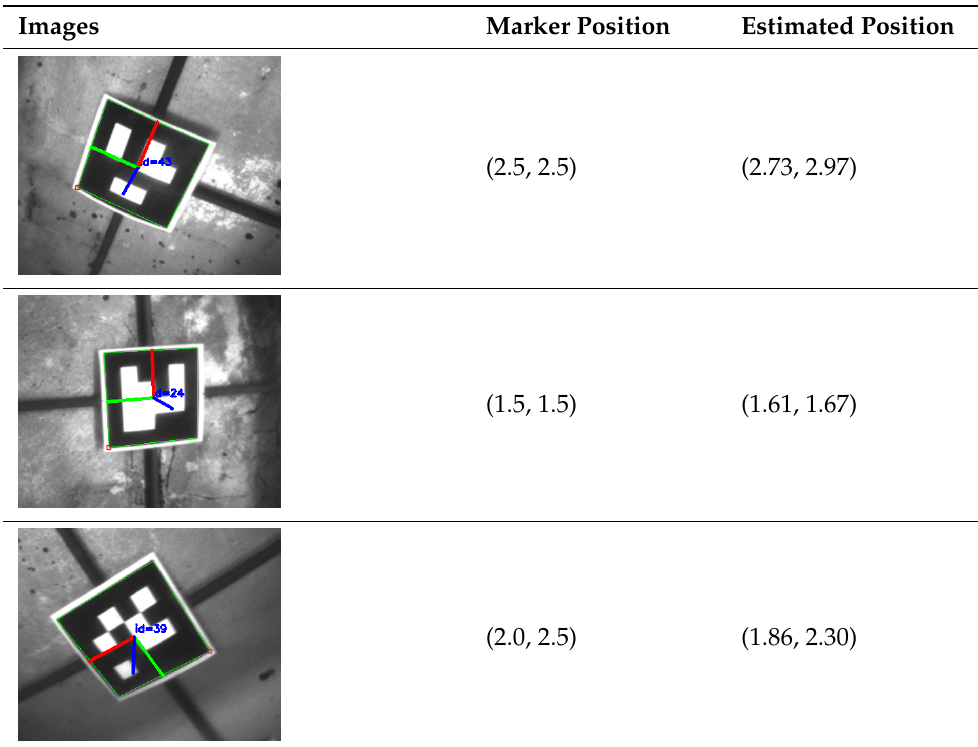
Table 1. Underwater ArUco method quantitative test (unit: